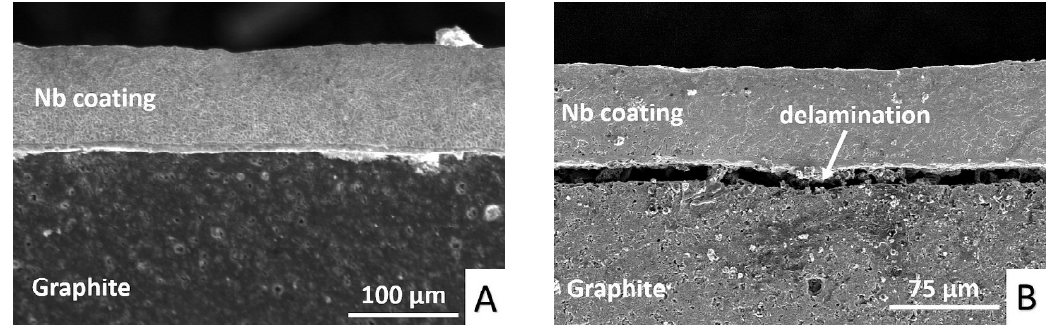
Fig. 5 . X-ray diffractograms of the zirconium coating surface (A) and the coating-graphite interface (B). The coating surface mostly contains zirconium oxides, whereas the interface is composed of zirconium oxides and zirconium carbide.